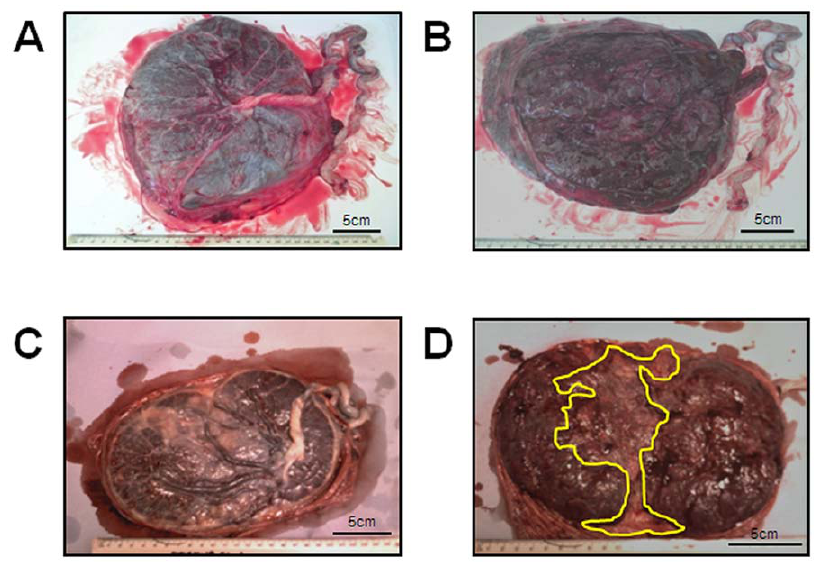
Figure 1. Examples of placental photographs from uncomplicated (A–B) and RFM (C–D) pregnancies. A ) Fetal side of a control placenta with a central cord insertion and normal distribution of chorionic plate vessels. B ) Shows the maternal side of a control placenta. C ) Shows the fetal side of a RFM placenta which is less round than the control example, and the cord is inserting laterally. D ) Shows the maternal side of a RFM placenta. The area highlighted by the yellow line shows an abnormal white area which was confirmed on the cut surface of the placenta.